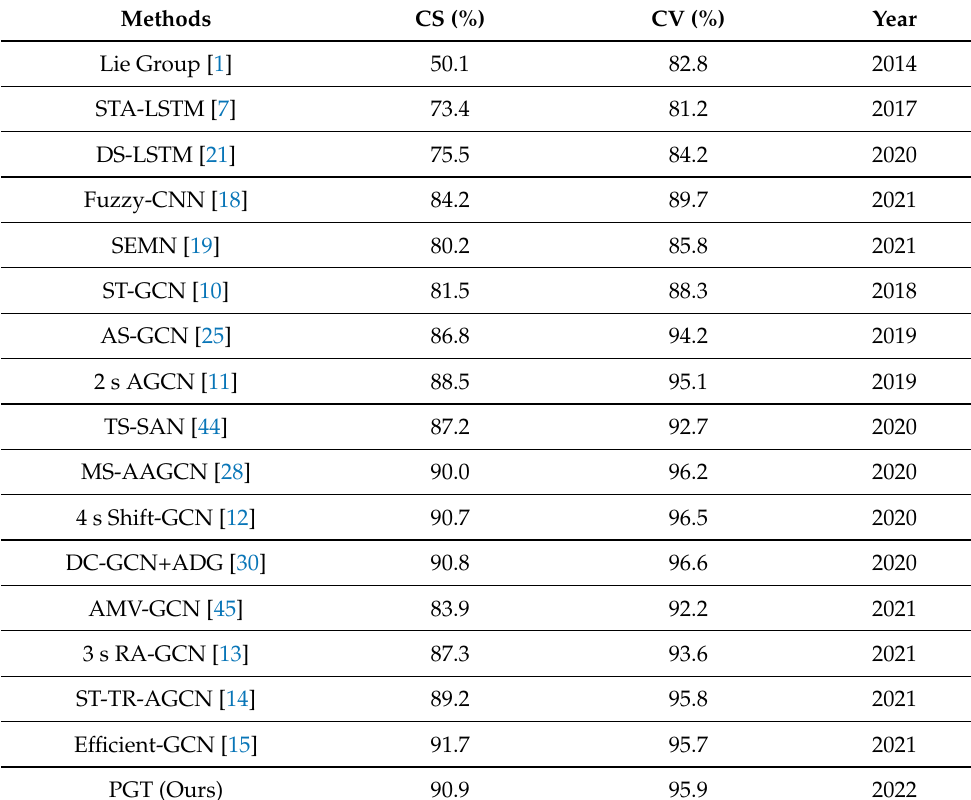
Table 5. Comparison of the experiment results on the NTU-RGBD 60